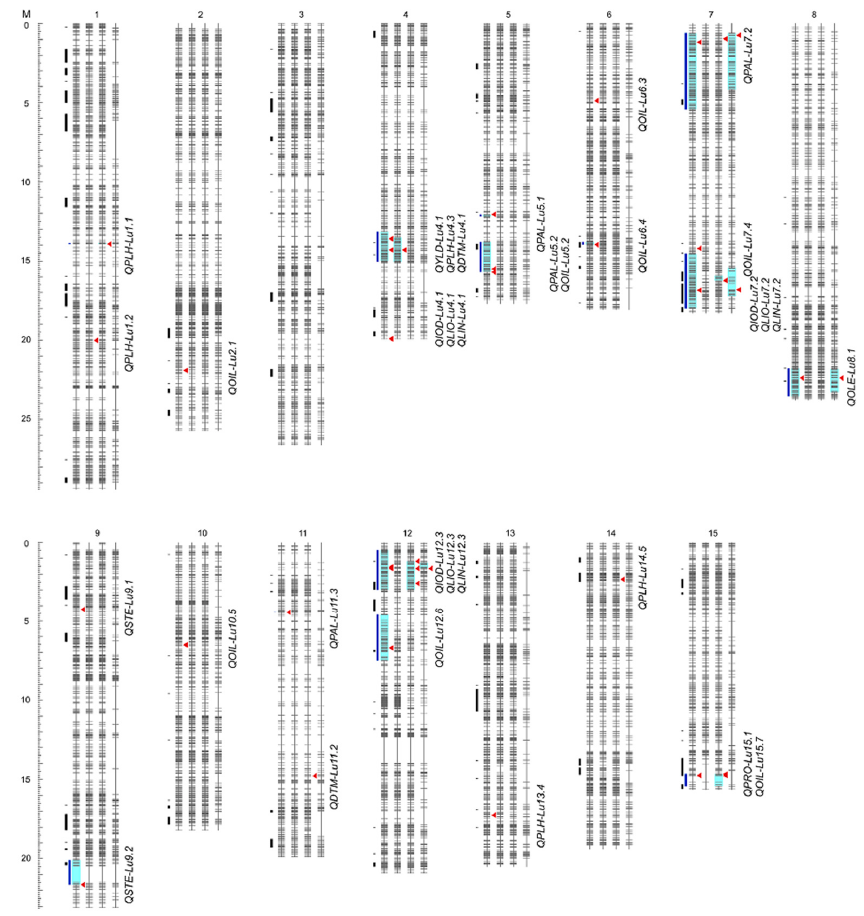
Figure 1. Distribution of 17,288 SNPs, 114 selective sweeps and 33 QTL on the 15 chromosomes of flax for each of three bi-parental populations BM, EV and SU and, for the merged population (BM + EV + SU). Four vertical bars from left to right for each chromosome represent the BM + EV + SU, BM, EV and SU populations, respectively. Short horizontal lines on bars represent SNPs. QTL regions are highlighted in cyan and by vertical blue lines. Red triangles identify QTL’s peak SNP. Selective sweeps are represented by short vertical black lines.